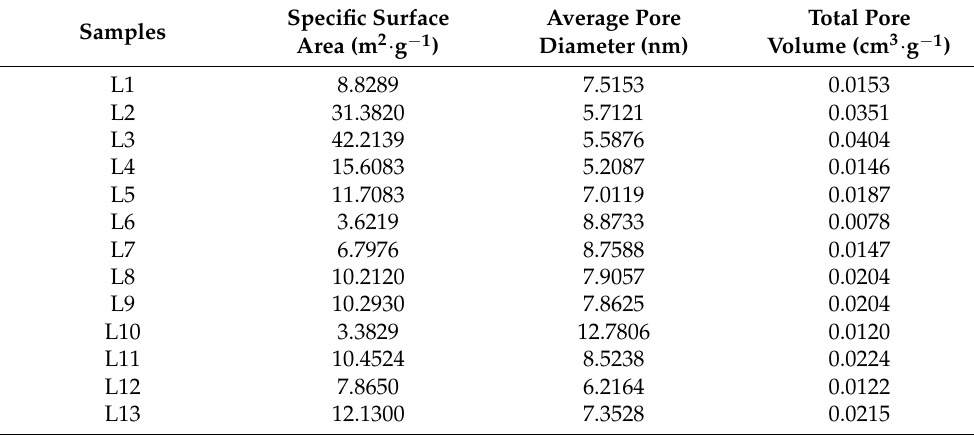
Table 2. Pore structure parameters of samples.